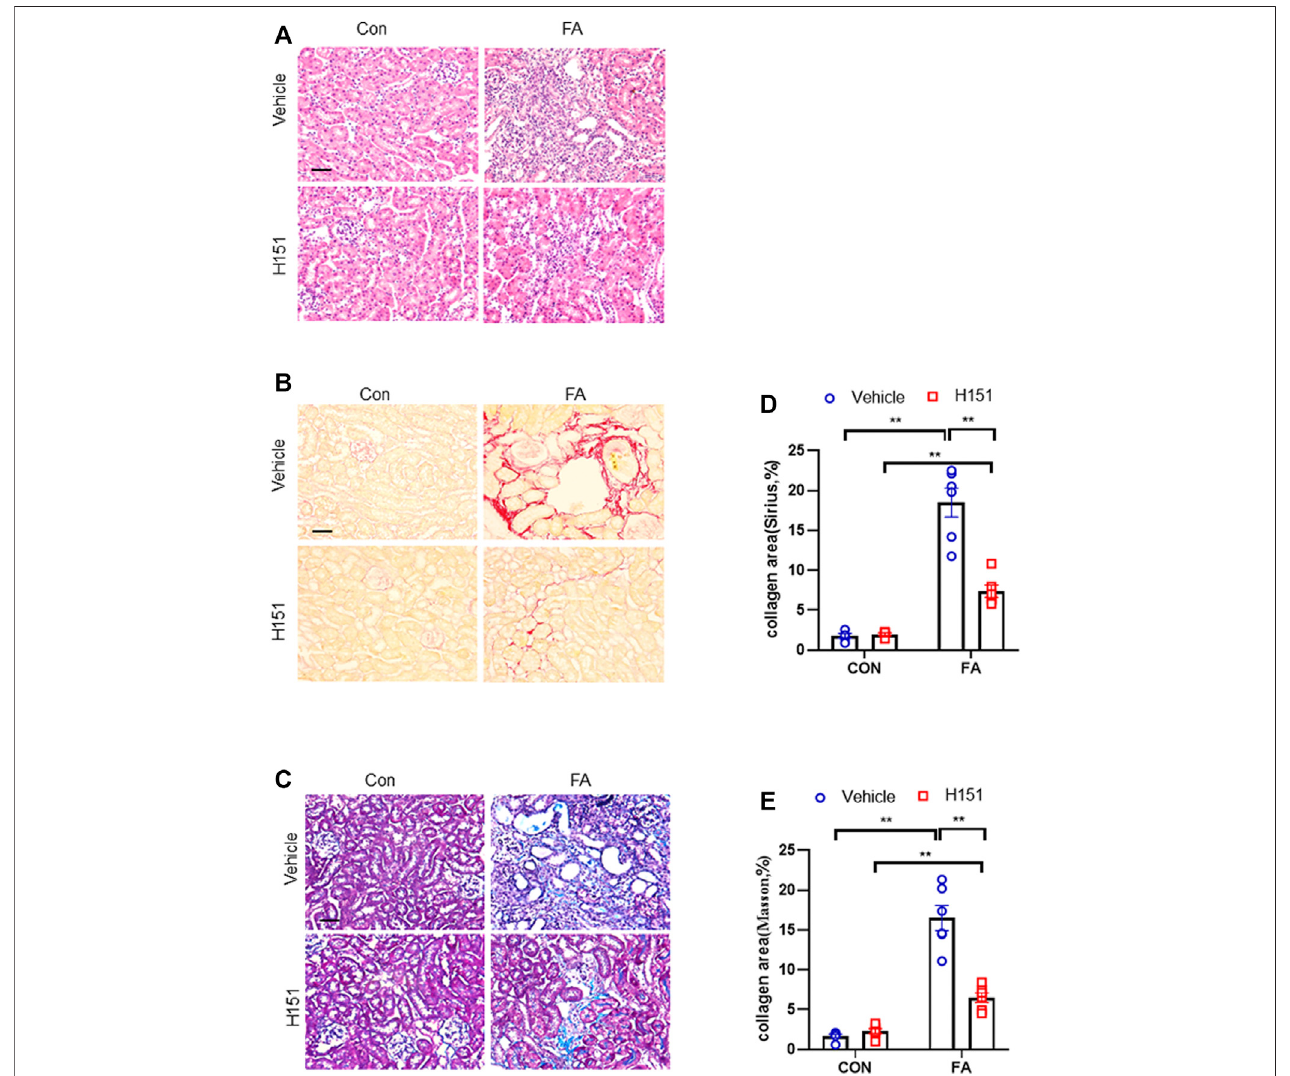
FIGURE3| PharmacologicalinhibitionofSTINGattenuatesprogressiverenal fi brosisinFAnephropathy. (A) Representativephotomicrographsofkidneyssections in each group stained with H&E. (B) Representative photomicrographs of kidney sections stained with Sirius red. (C) Representative photomicrographs of kidney sections stained withMasson ’ strichrome. (D,E) Quantitative analysisofinterstitial collagenarea stained withSiriusred or Masson ’ strichromeinthe kidneys. ** p < 0.01; n = 6 in each group; Scale bar: 50 μ m.